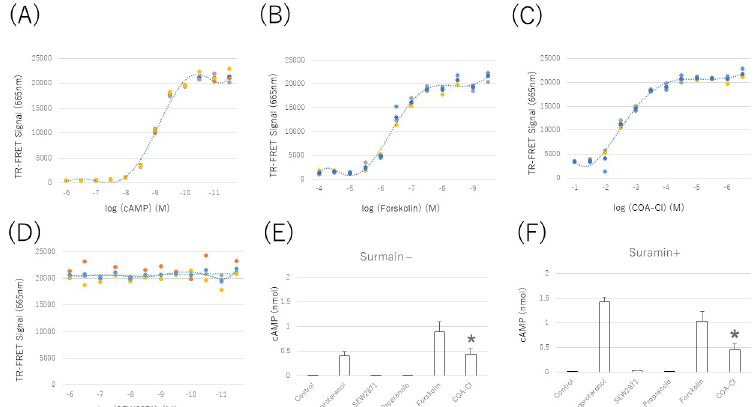
Fig 6. cAMP standards (10 pM-1 μ M; half-log increments) were used to create a concentration calibration based on the decreasing time-resolved fluorescent resonance energy transfer (TR-FRET) in hiPSC-CMs (A). Forskolin (1nM- 100 μ M; half-log increments) caused a concentration-dependent decrease in TR-FRET and thus an increase in cAMP. The dose response curve was drawn using the mean values (B). COA-Cl (100 μ M-10M; half-log increments) caused a concentration-dependent decrease in TR-FRET and thus an increase in cAMP. The dose response curve was drawn using the mean values (C). In hiPSC-CMs, COA-Cl (1 mM), ISO (10 nM), and FSK (10 μ M) substantially increased the cAMP level compared to the basal cAMP level in untreated controls. Treatment with SEW2871 (20 nM) and PRP (10 nM) did not significantly alter the cAMP levels compared to control. � P values of < 0.05 were considered to represent a statistically significant difference compared to control (n = 5–8) (D). HiPSC-CMs treated with Suramin (100 μ M), COA-Cl (1 mM), ISO (10 nM), and FSK (10 μ M) showed significantly increased cAMP levels compared to the basal cAMP level in untreated controls. Treatment with SEW2871 (20 nM) and PRP (10 nM) did not significantly alter the cAMP level compared to control. � P values of < 0.05 were considered to represent a statistically significant difference compared to control (n = 5–8) (E, F). � P < 0.05 significant compared to control. These results showed that COA-Cl increased the cAMP levels of hiPSC-CMs similarly to Isoproterenol and Forskolin, but not through A1R or S1P1R activation (n =